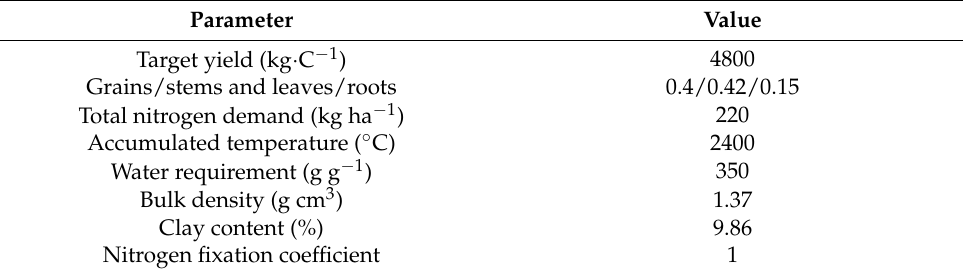
Table 2. Crop parameters simulated by the DNDC model.